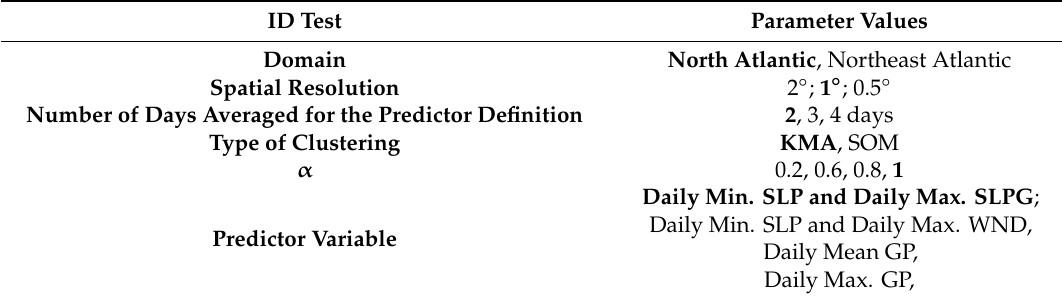
Table 1. The di ff erent set-ups were tested in the sensitivity analyses. The bold parameters are the parameters used in the optimal model, SD1, after Section